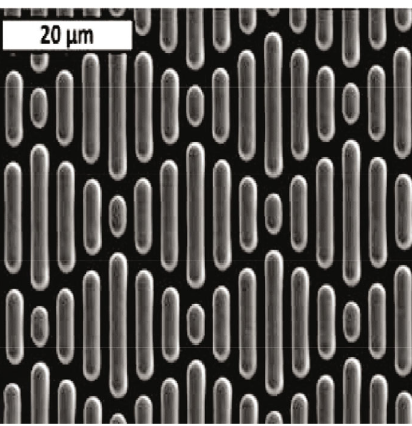
Figure 18: Drag reduction coating inspired by shark skin antifouling [45].